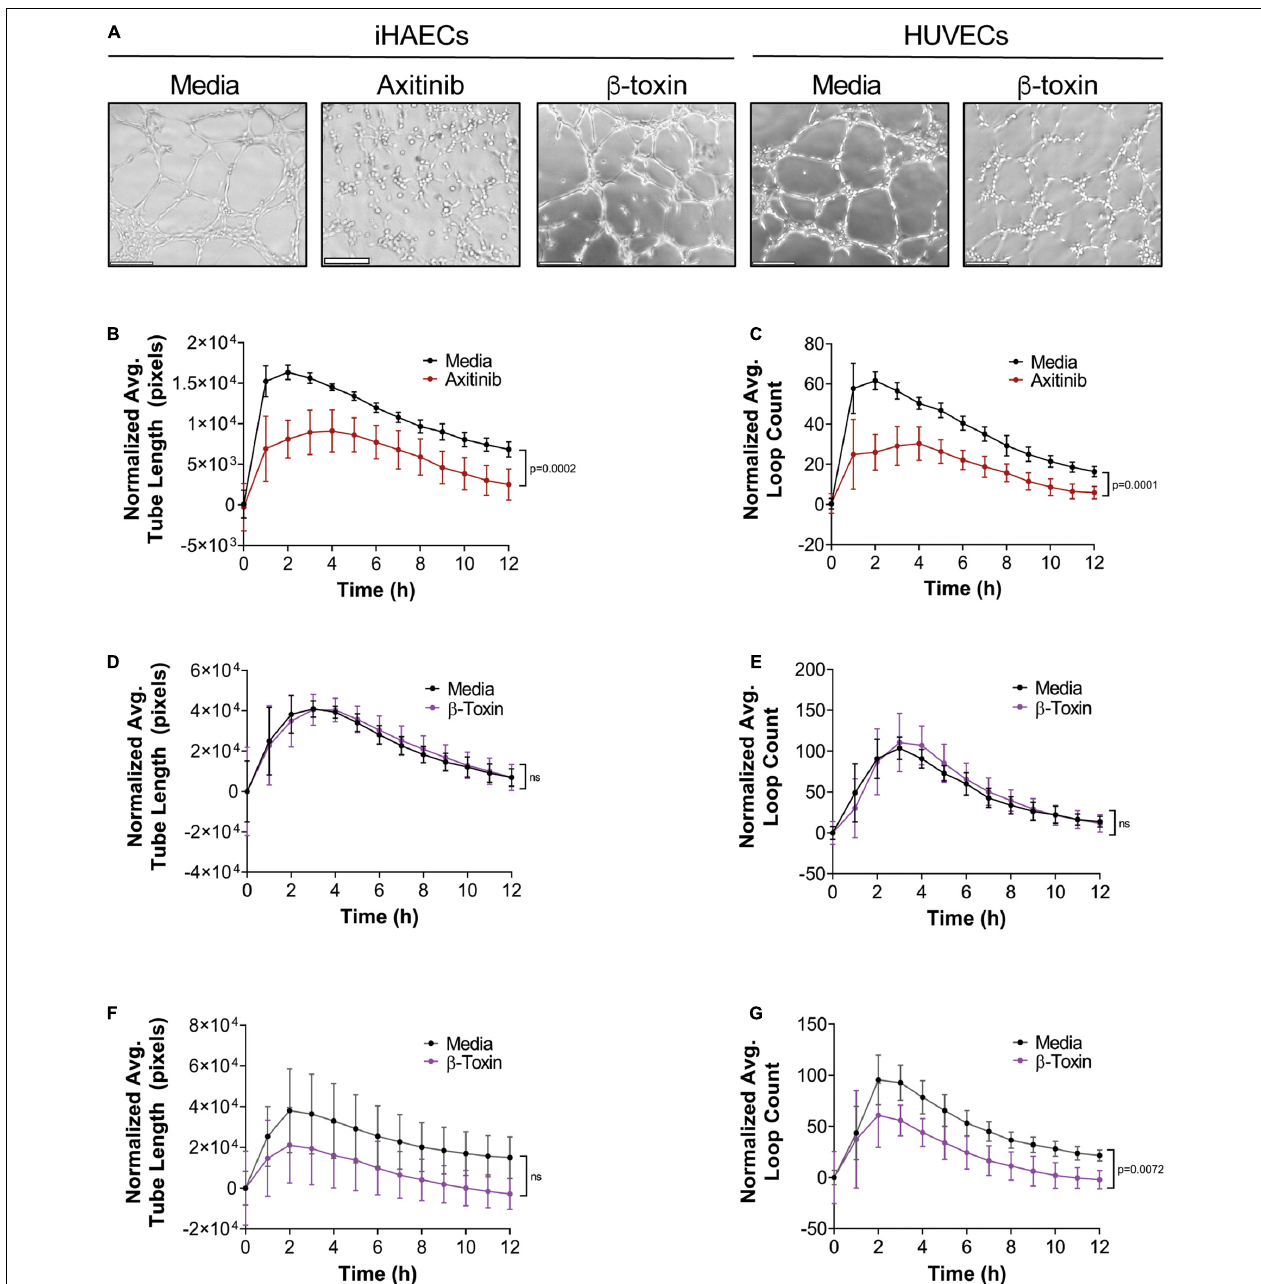
FIGURE 5 | β -toxin has differential effects on tube formation. iHAECs seeded on GFR-Matrigel were treated with either axitinib (30 µ M) or β -toxin (50 µ g mL − 1 ) and tube formation imaged every 1 h for 12 h. (A) Phase-contrast microscopy at 3 h. Scale bar = 200 µ m. (B) Average tube length over time of iHAECs ± axitinib. (C) Average loop count over time of iHAECs ± axitinib. (D) Average tube length over time of iHAECs ± β -toxin. (E) Average loop count over time of iHAECs ± β -toxin. (F) Average tube length over time of HUVECs ± β -toxin. (G) Average loop count over time of HUVECs ± β -toxin. (B–G) Results are means ± SD for at least 6 independent experiments with five replicates each. Statistical significance determined by two-way repeated measures